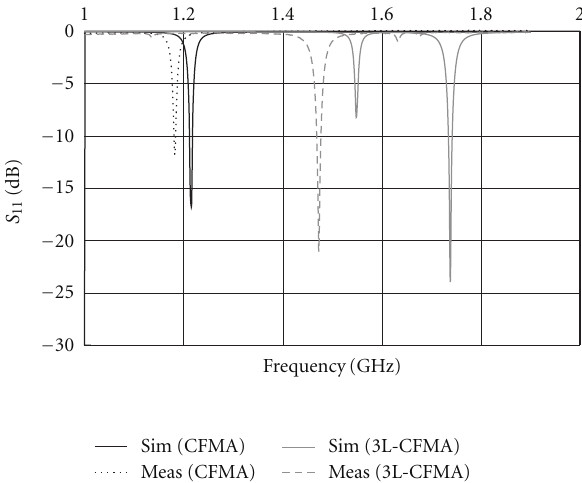
Figure 12: Simulated and measured S 11 characteristics.